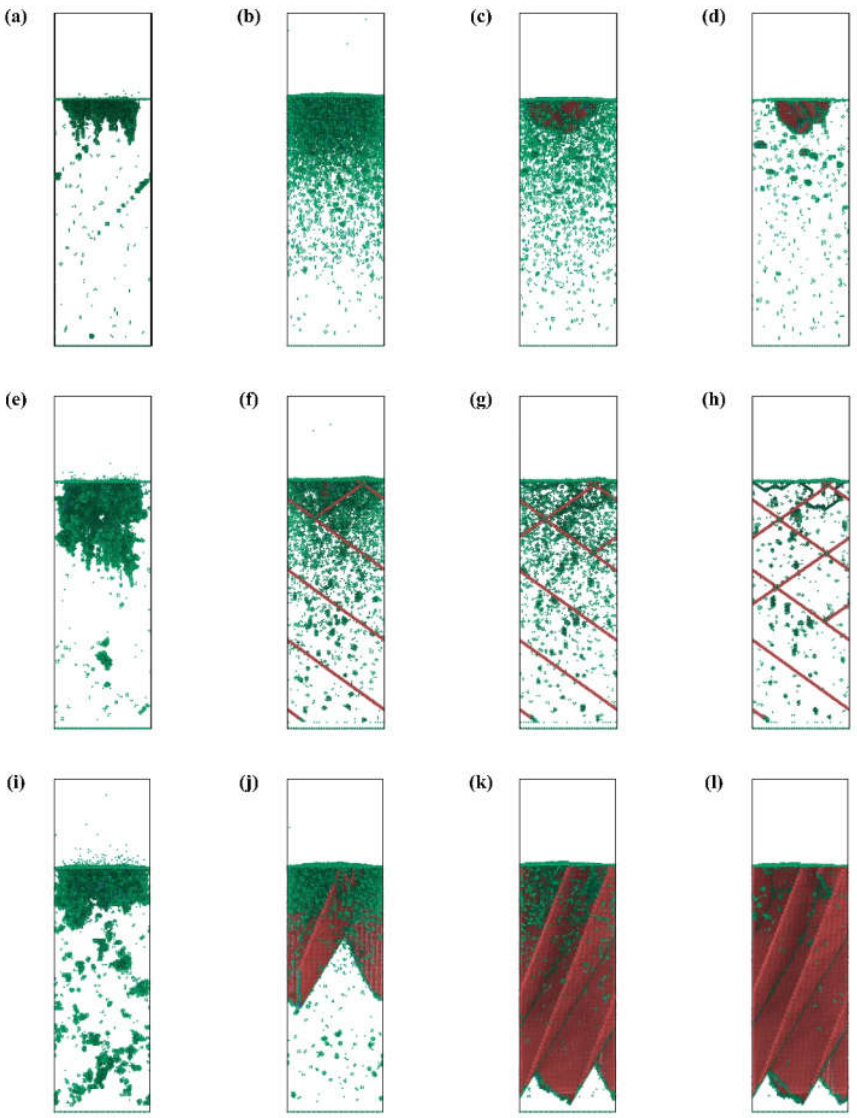
Figure 10. The evolution of subsurface damage, of Al(001) ( a ) 200 fs ( b ) 20900 fs ( c ) 80000 fs ( d ) 240000 fs, of Al(110) ( e ) 200 fs ( f ) 20900 fs ( g ) 80000 fs ( h ) 240000 fs, of Al(111) ( i ) 200 fs ( j ) 20900 fs ( k ) 80000 fs ( l ) 240000 fs. Figure 11 gives the evolution of dislocation length and atom number in the Al(001), Al(110), and Al(111) during total IBS machining. The IBS mainly induces the Shockley dislocation and stair-rod dislocation generated in the Al(001), Al(110), and Al(111). It can be observed from Figure 11a–c that the dislocation length firstly increases and then tends